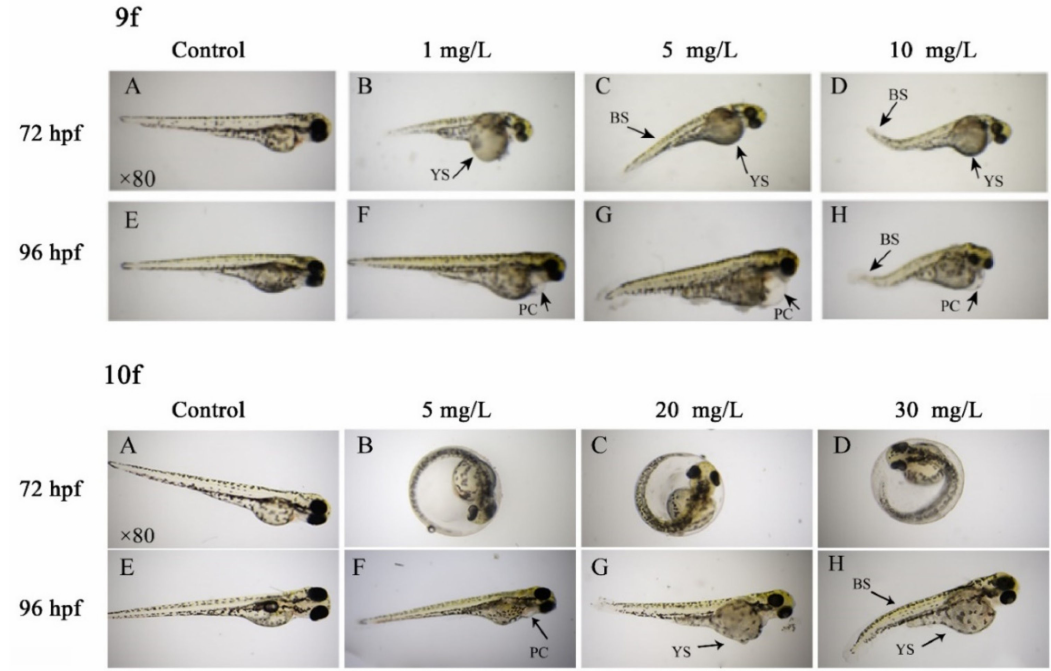
Figure 4. Zebrafish embryo malformation after exposure to compounds 9f and 10f . Note: PC, pericardial cyst; YS, yolk sac; BS, bent